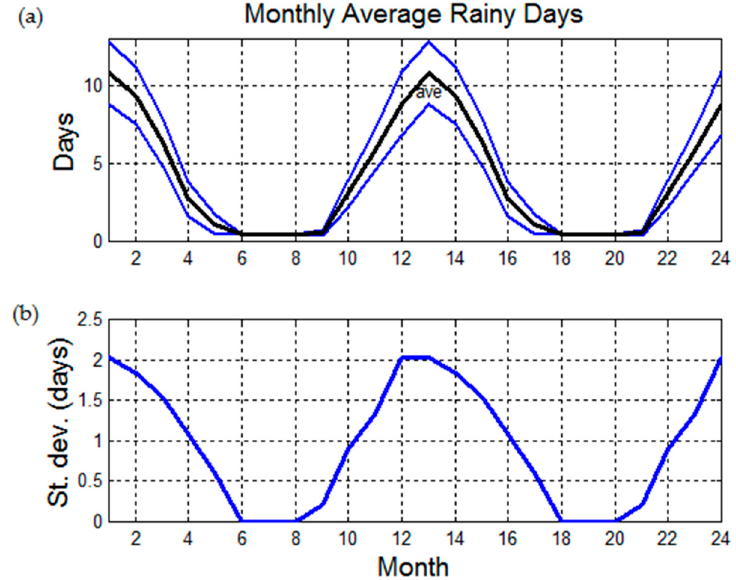
Figure 5. (a): average value and ± 1 standard deviation of the monthly rainy days concerning 184 localities of the Holy Land in the years 1990–2015, from January (1) to December (12). (b): standard deviation. Notice that each annual cycle is repeated twice for showing continuity.